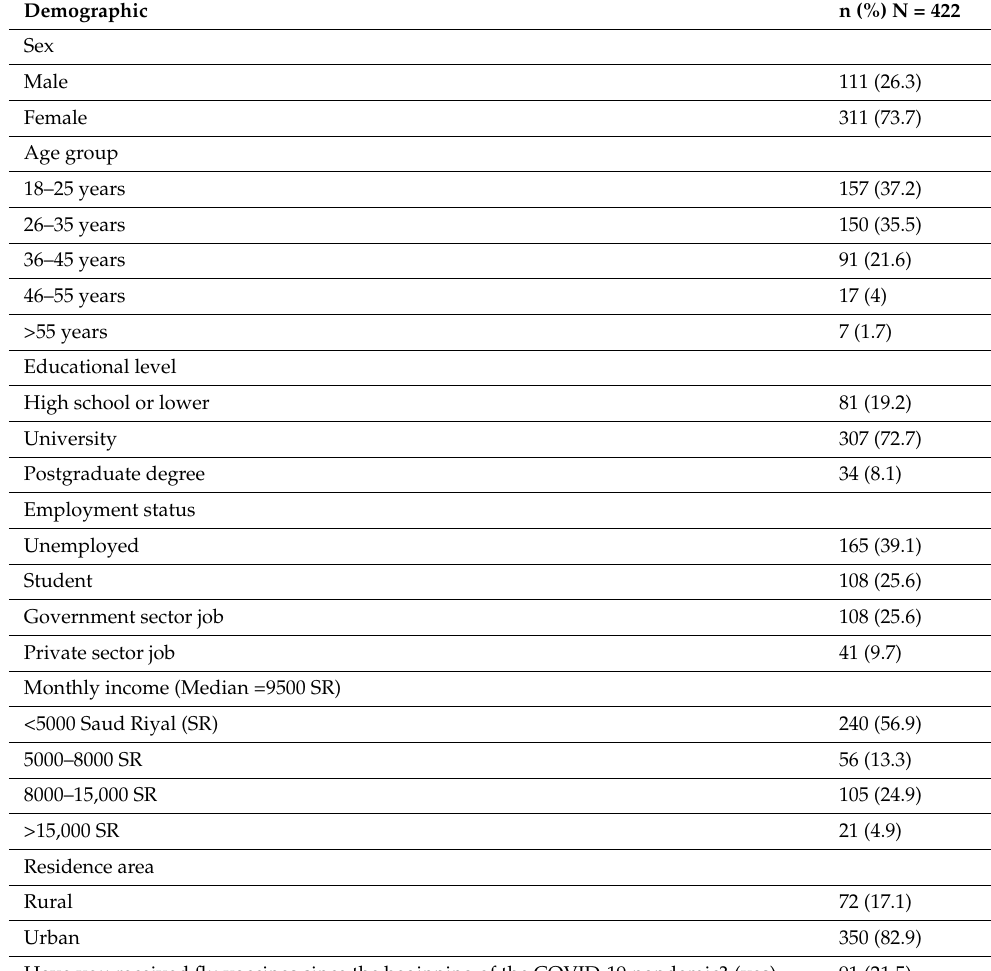
Table 1. Demographic information about the